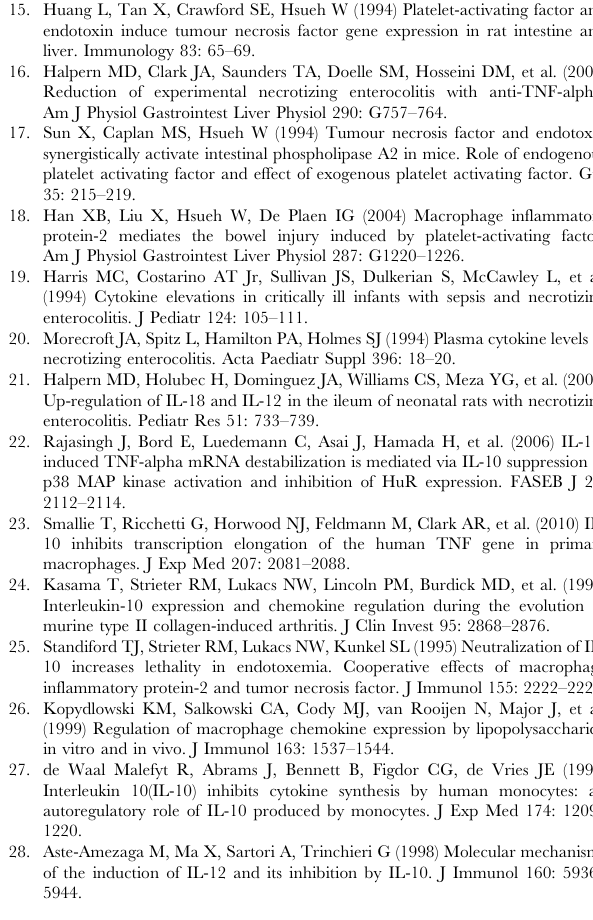
Figure S2 Effect of heat-killed LGG on IL-10 signaling was analyzed in whole colon by qRT-PCR 6 hours after gavage feeding. Heat-killed LGG had no effect on IL-10, IL- 10R1 or IL-10R2 (A). IL-12, IL-18 and IL-6 were analyzed 24 hours after gavage of live LGG (B). Data are depicted as mean 6 SEM (n= 5 2 7 mice per condition, *p ,